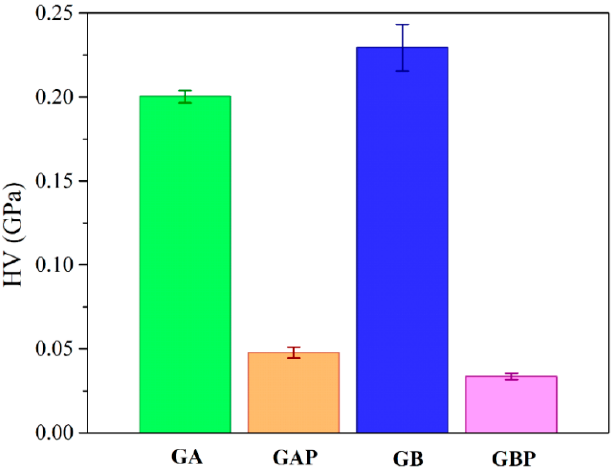
Figure 8. Results of Vickers micro-hardness test.